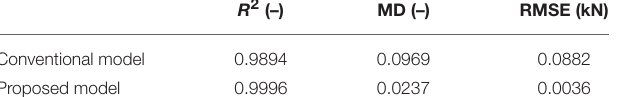
TABLE 1 | Evaluation criteria of accuracy.